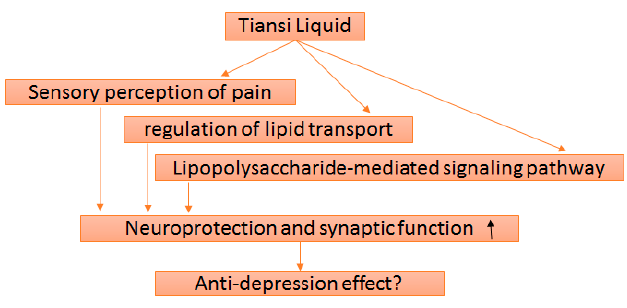
Figure 5. Mechanistic effect of Tiansi Liquid against depression.